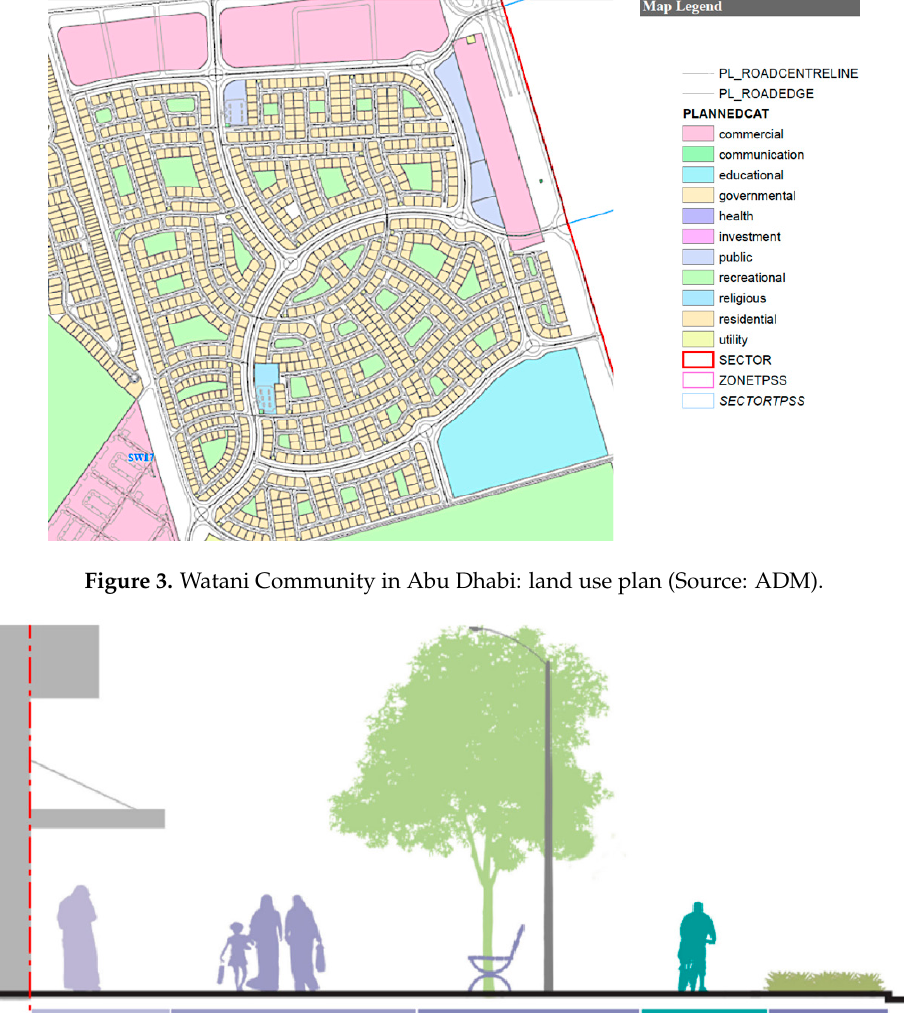
Figure 3 . Watani Community in Abu Dhabi: land use plan (Source: ADM).